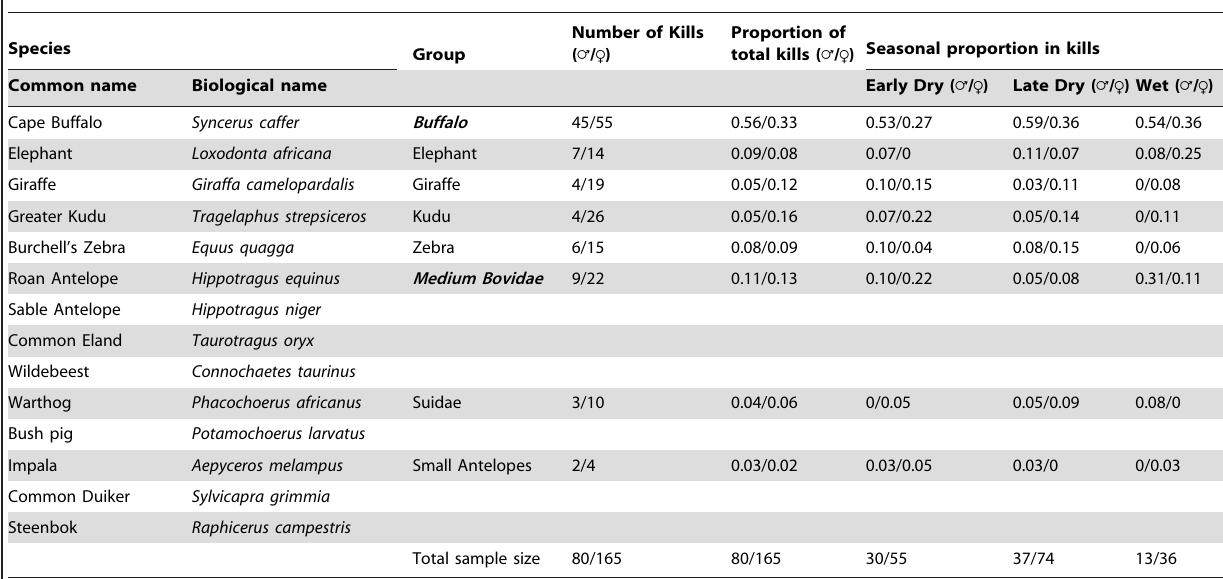
Table 1. Lion prey species found at kills classified in 8 groups and their respective proportions relative to frequency of